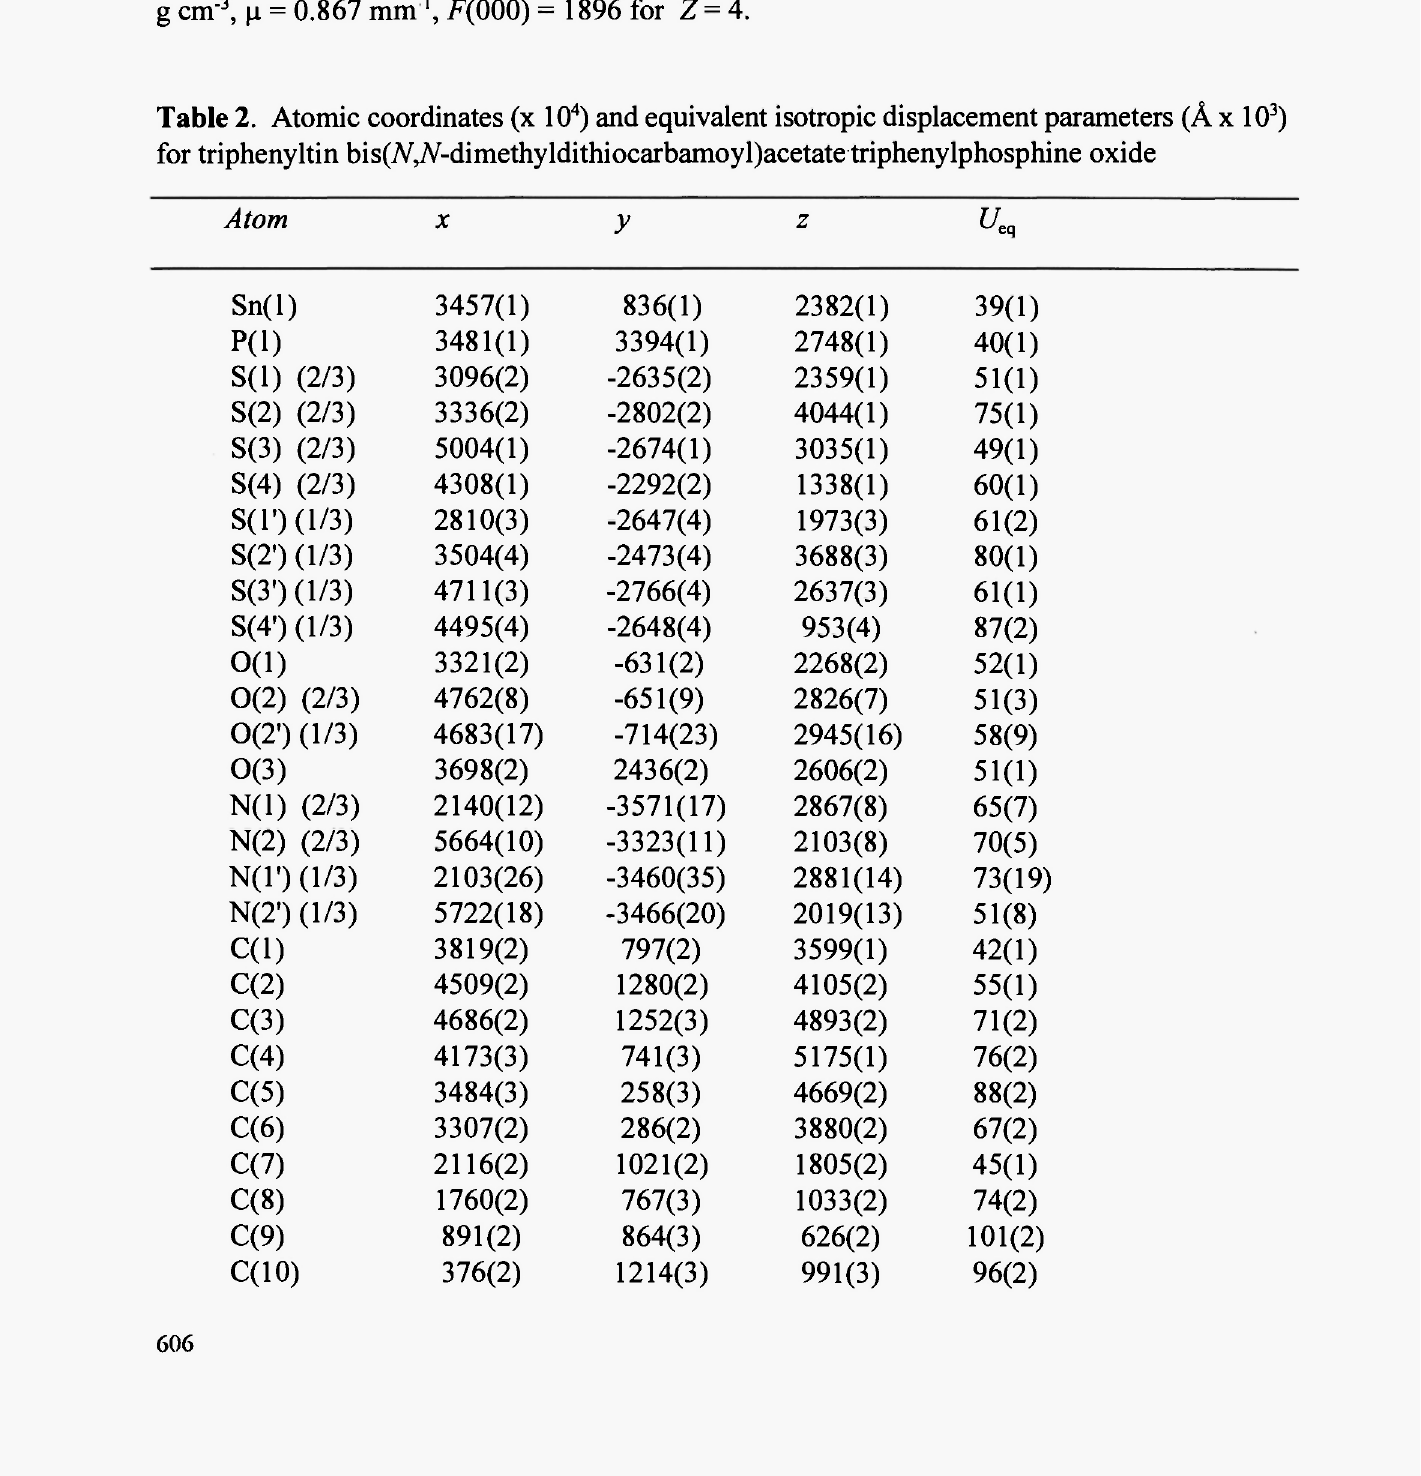
Table 2. Atomic coordinates (χ 10 4 ) and equivalent isotropic displacement parameters (Α χ 10 3